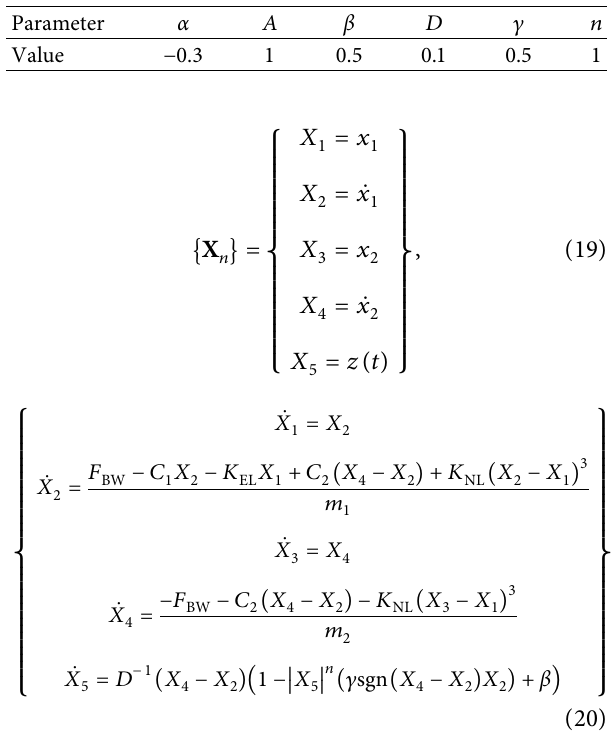
Table 1: Parameters of HNES (dimensionless).